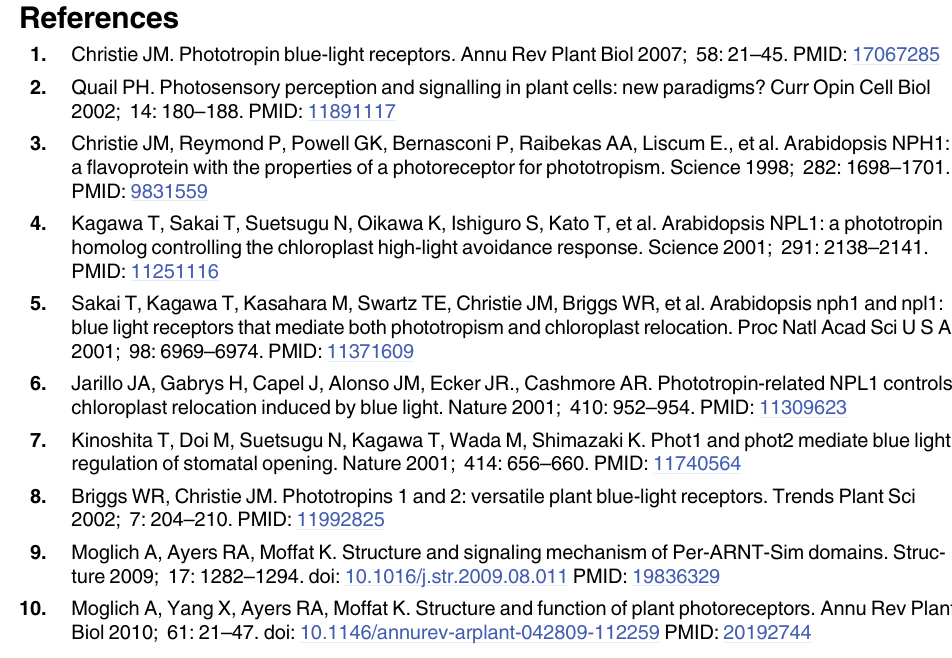
S1 Fig. Estimation of molecular weight of mutants by size exclusion column chromatogra- phy. Ovalbumin (44 kDa), Conalbumin (75 kDa), Aldolase (158 kDa) and Ferritin (440 kDa) were used for the molecular weight standards (open black circle). The other symbols, see the Figure. (TIF) S2 Fig. Mass spectra of trypsin-digested polypeptides from band-1 (A) and band-2 (B) in Fig 5 (A). S3 Fig. Time course of the peptide mapping of At phot1 LOV2-J α , (A), and LOV2-linker, (B). Samples were digested by trypsin in the dark (D) or under BL irradiation (L). The four ar- rowheads indicate the bands of major proteolytic products. S1 Table. Primer sets used for site-directed mutagenesis. S2 Table. Assignment of polypeptides of band-1 and band-2 in S1